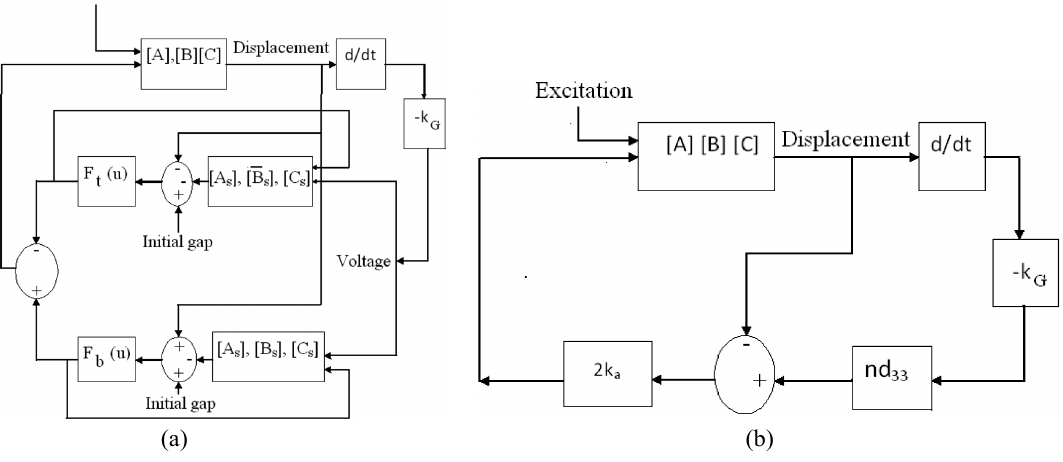
Fig. 6. (a). Block diagram showing the non-linear system; (b). Block diagram showing the linearized and simpli fi ed